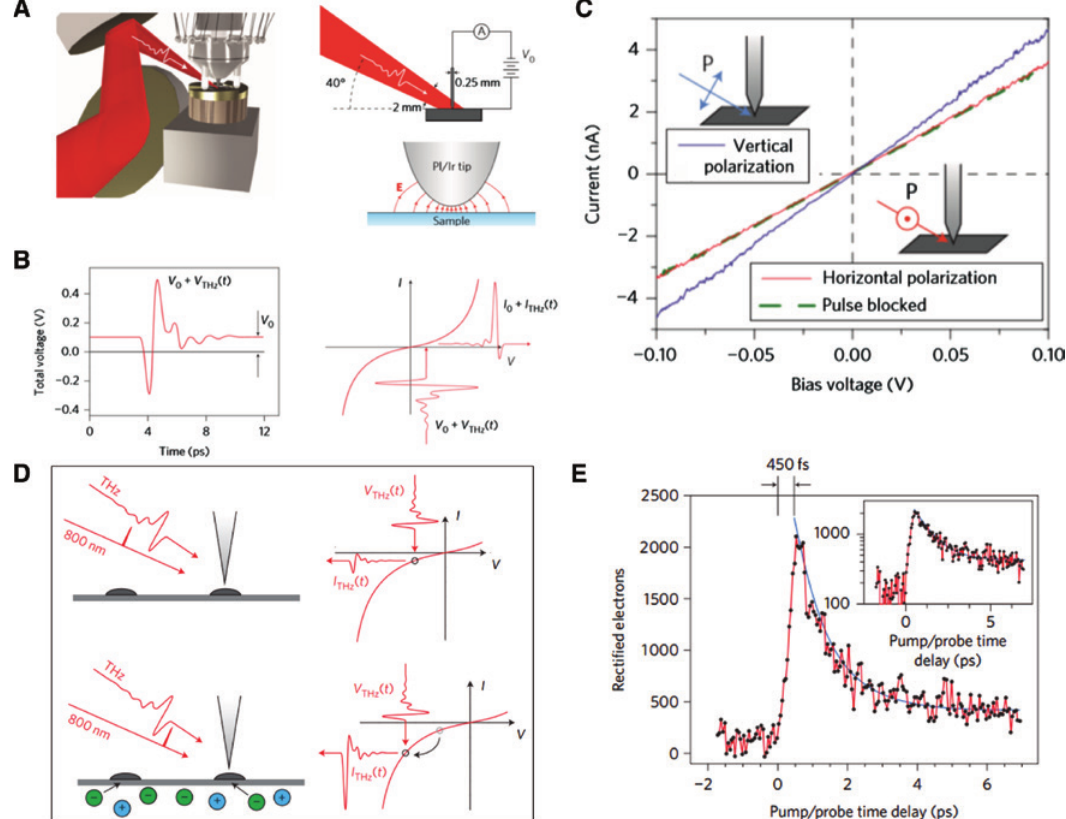
Figure 3: Ultrafast THz-STM